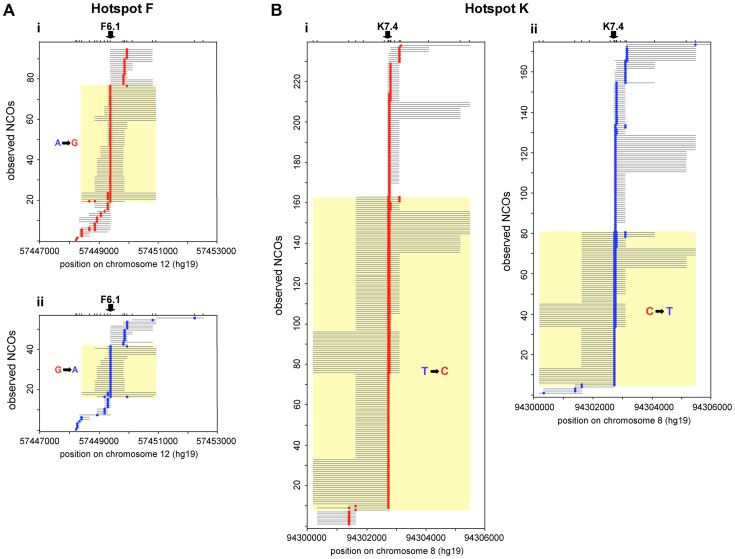
Transmission distortion specifically in NCOs.NCO recombinants detected in reciprocal recombination assays for 10 men heterozygous at F6.1 in hotspot F (A), and 8 men heterozygous at K7.4 in hotspot K (B). (i) Assays with selector sites in phase with the parental haplotype carrying the under-transmitted allele (F6.1A or K7.4T, respectively) and thus with recombinants carrying marker(s) from the haplotype bearing the over-transmitted allele (F6.1G or K7.4C respectively) are shown in red. (ii) Opposite phase recombinants are shown in blue. The structure of each observed NCO is shown separately, with converted markers indicated by coloured circles and maximum conversion tract lengths shown by grey lines. NCOs that span the key markers (arrowed) are indicated by yellow boxes; significantly more of these events are seen in (i) than in (ii) (hotspot F: P = 0.00016; hotspot K: P = 3.0×10−7; two-tailed exact binomial tests). Events outside the yellow boxes that do not encompass the key markers, show no disparity in frequency between orientations (i) and (ii) (hotspot F: P = 0.457; hotspot K: P = 0.295; two-tailed exact binomial tests). Note that tract length estimation is difficult because minimal conversion tracts that include only the converted markers almost certainly underestimate the true conversion tract length while maximal lengths, which correspond to the entire interval between flanking non-converted markers, can be heavily influenced by marker distribution. The minimum conversion tract length for any single site event is clearly 1 bp whilst for multisite events it was 83 bp at hotspot F and 25 bp at hotspot K. However, the maximum lengths of ranged from 118 bp to 2504 bp for hotspot F and 77 bp to 4970 bp for hotspot K.